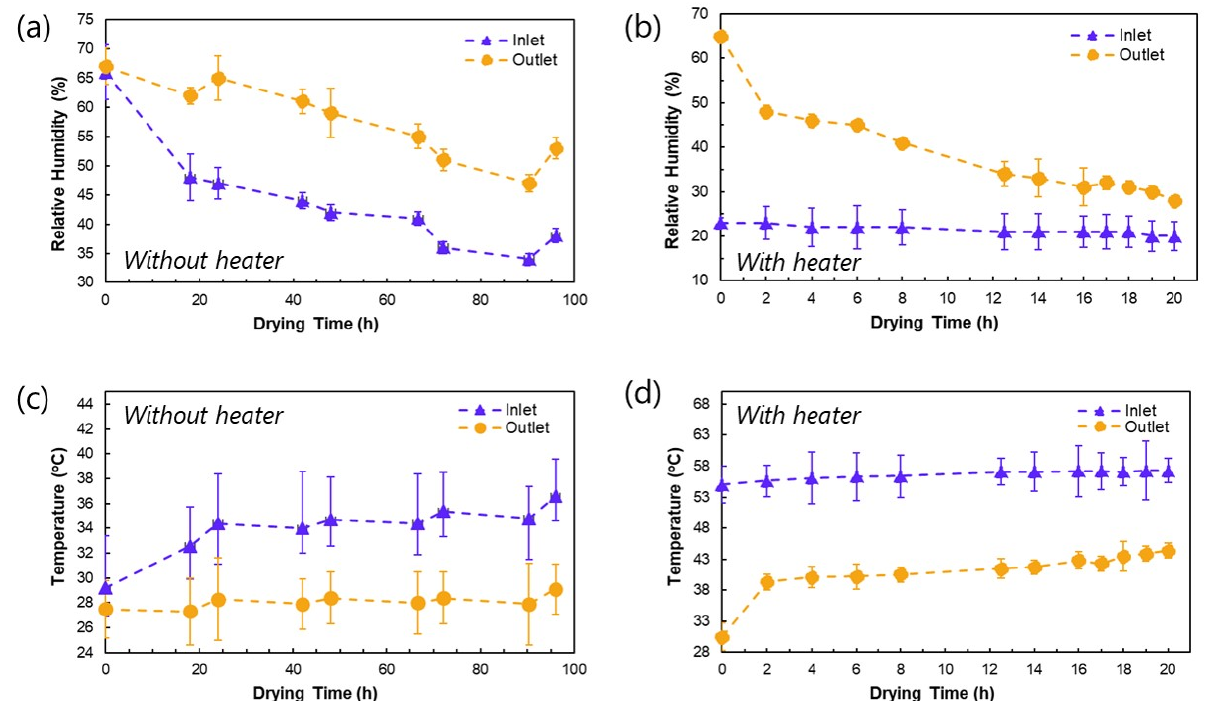
Figure 2. Relative humidity profiles in the drying cabinet of the Polydryer ( a ) without and ( b ) with the operation of a heater; and temperature profiles in the drying cabinet of the Polydryer ( c ) without and ( d ) with the operation of a heater using sliced ginger as the samples.